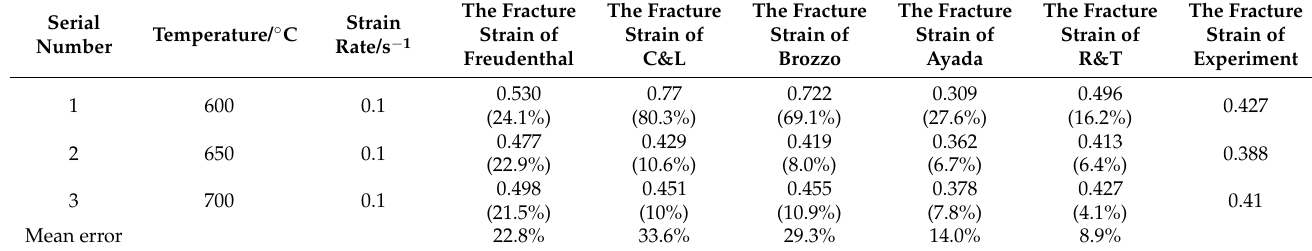
Table 9. The fracture strain obtained by simulation and experiment.